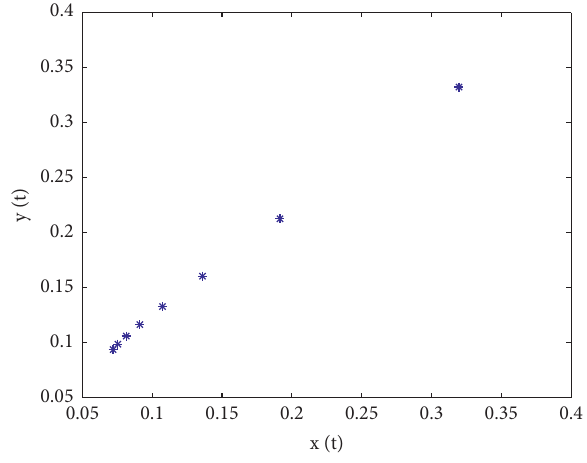
Figure 3: Phase plot of